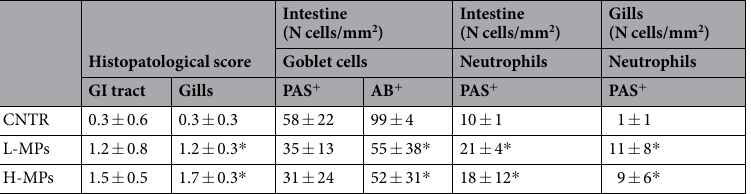
Table 2. Summary of quantitative data yielded from histological analyses. The histopathological score was graded as 0: healthy tissues, 1: mild alteration, 2: gross alteration. Results are expressed as the mean ± SD (N = 3 specimens per group). * Significantly different from control p < 0.05.